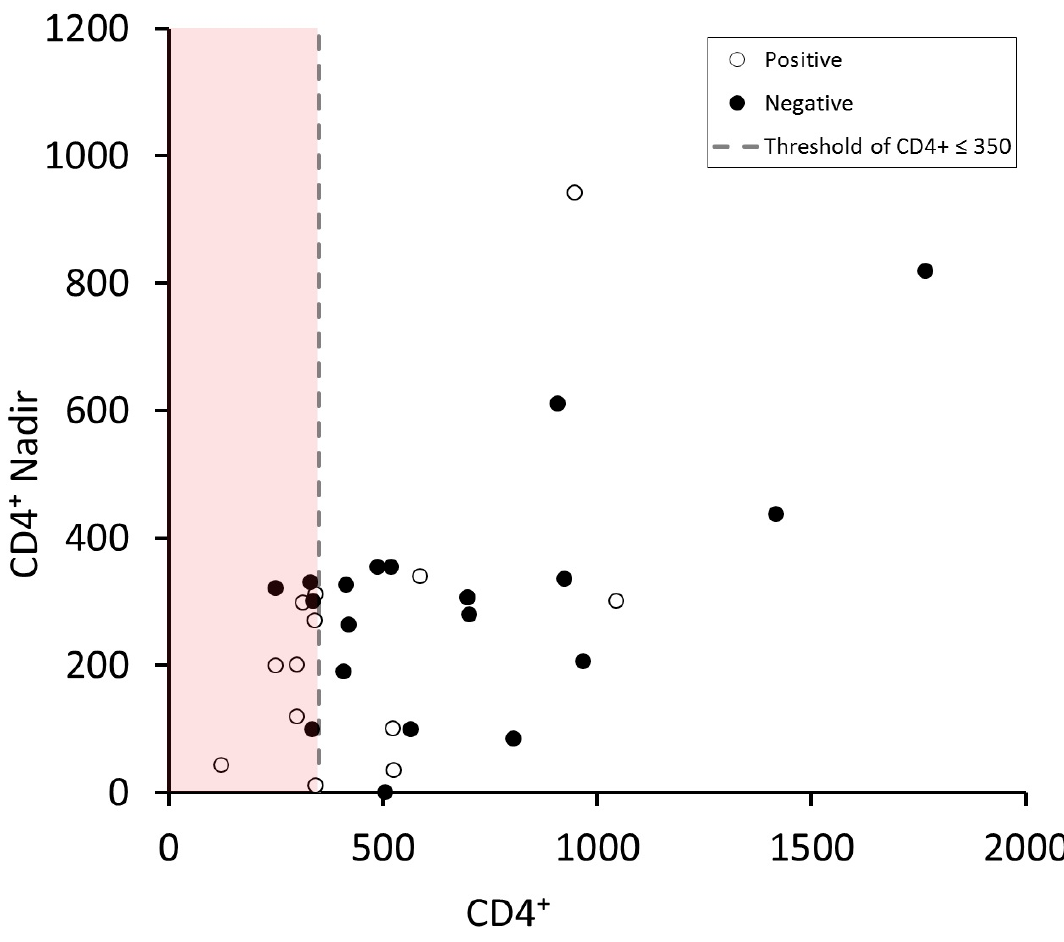
Figure 3. Correlation between CD4 + and CD4 + nadir white and black circles represent the negative and positive patients. (CD4 expressed in cells / mm 3 )